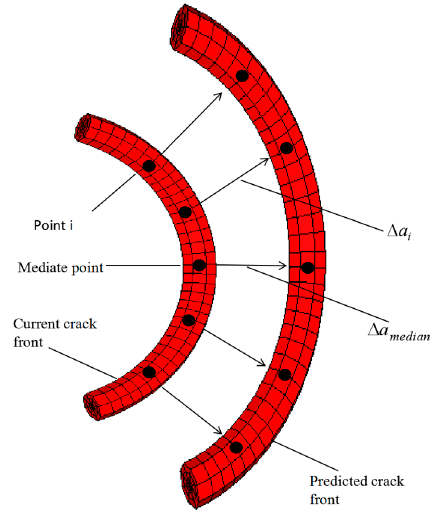
Figure 1. Principle of crack propagation simulation.